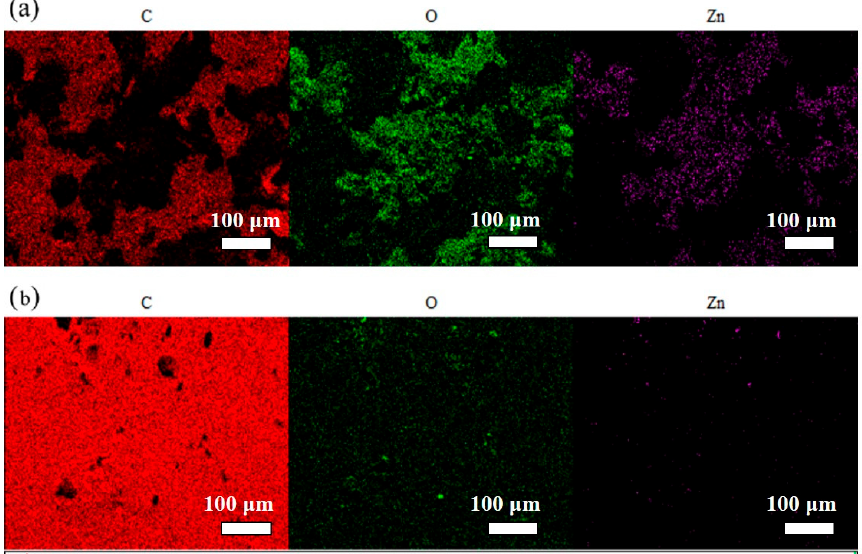
Figure 2. The EDS mapping and spectra for the coated samples ( a ) ZRPs and ( b ) Gr0.6-ZRPs after immersion in a 3 wt. % NaCl solution for 25 days (carbon with red, oxygen with green, and zinc with purple).